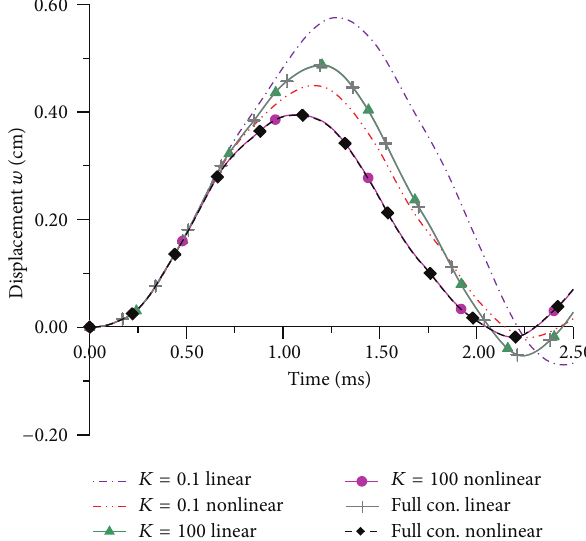
Figure 7: Time history of the deflection 𝑤 (cm) at the middle point A of the free edge of the stiffened plate of Example 1 for various values of connectors’